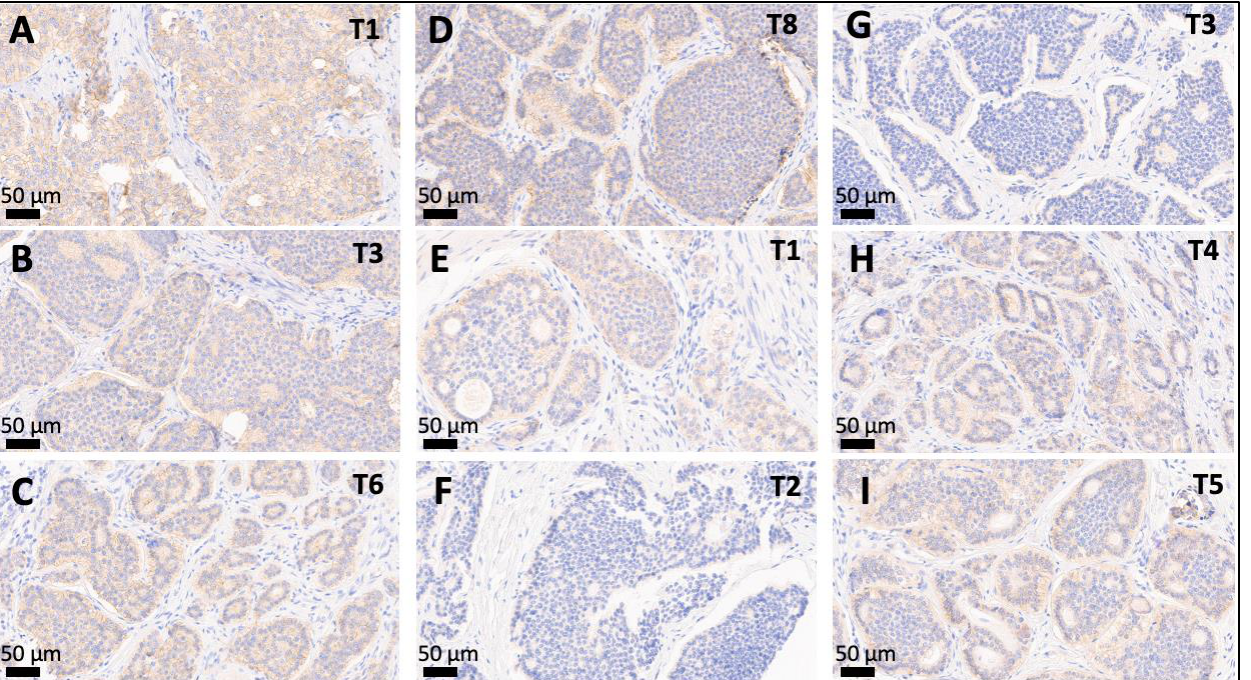
Figure 3. Intertumoral variation of SSTR2 status between multifocal SI-NETs. ( A – D ): Multifocal SI-NET with an SSTR2 3+ leading primary NET ( A ) accompanied by a smaller SSTR2 2+ synchronous NETs ( B – D ). ( E – H ): Discordant multifocal SI-NET with an SSTR2 2+ leading primary NET (( C ), proliferation < 1%) accompanied by two smaller synchronous SSTR2-negative NETs ( F , G ), and another two SSTR2 2+ NETs ( H , I ). Depicted are the leading primary NET and selected smaller synchronous jejunoileal NETs (20×) from patients with multifocal SI-NET: T1: leading primary NET, T*: number of the respective smaller synchronous NET within the same patient. Abbreviations: SSTR2 = somatostatin receptor 2a.